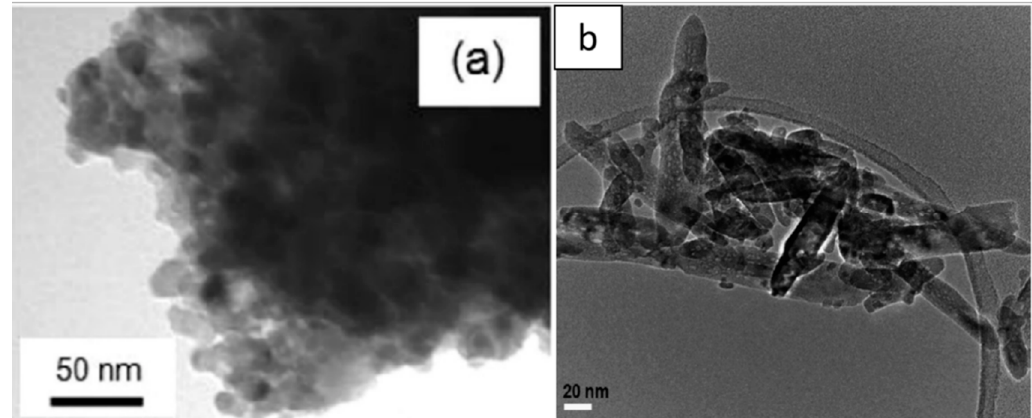
Figure 12. TEM micrographs of ( a ) TiO 2 anatase spherical sample calcined at 500 °C from [43] (reproduced with permission from F;.R. Cesconeto et al., Ceramics International; published by Elsevier, 2018) and ( b ) TiO 2 rutile nanorod sample calcined at 500 °C from [73] (reproduced with permission from P. Periyat et al., Materials Science in Semiconductor Processing; published by Elsevier, 2015).